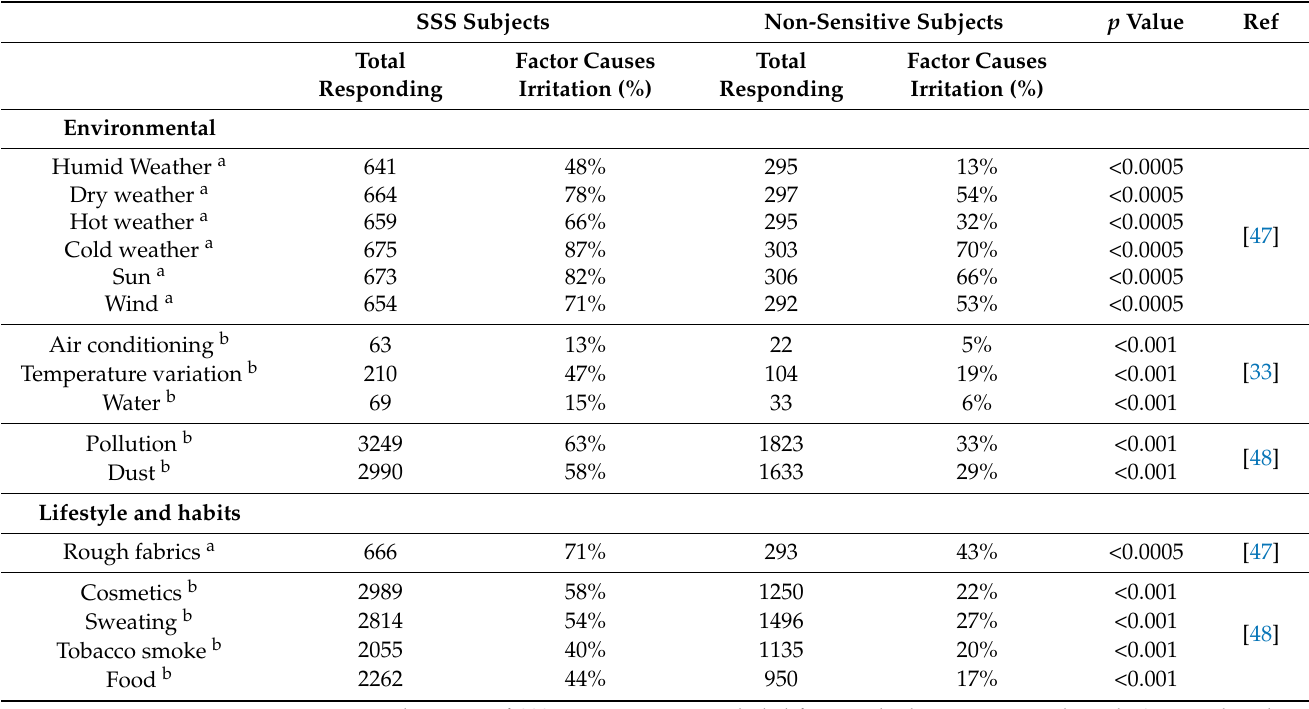
Table 3. Reported Environmental and Lifestyle Triggers of